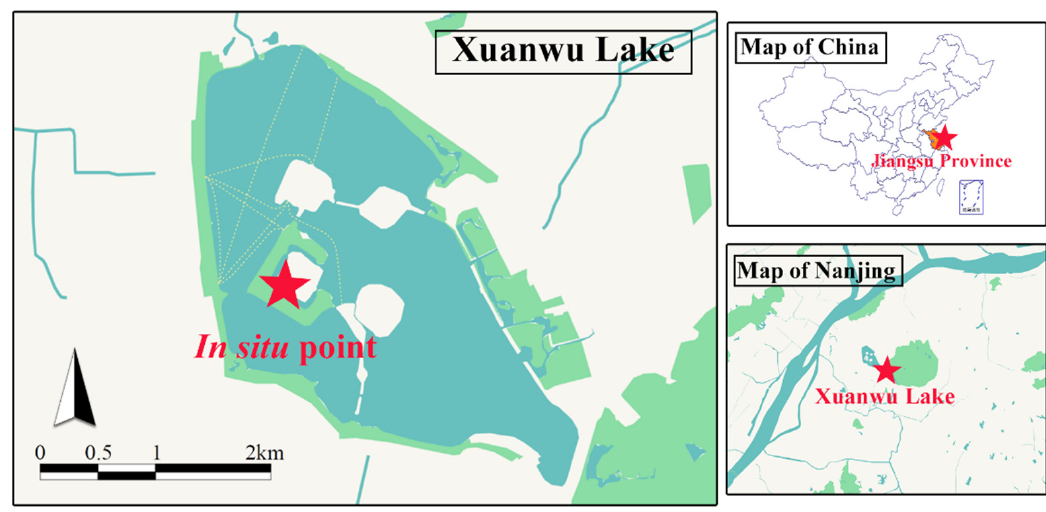
Figure 1. Location of study area and in situ cultivation site at Xuanwu Lake, Nanjing, East China.